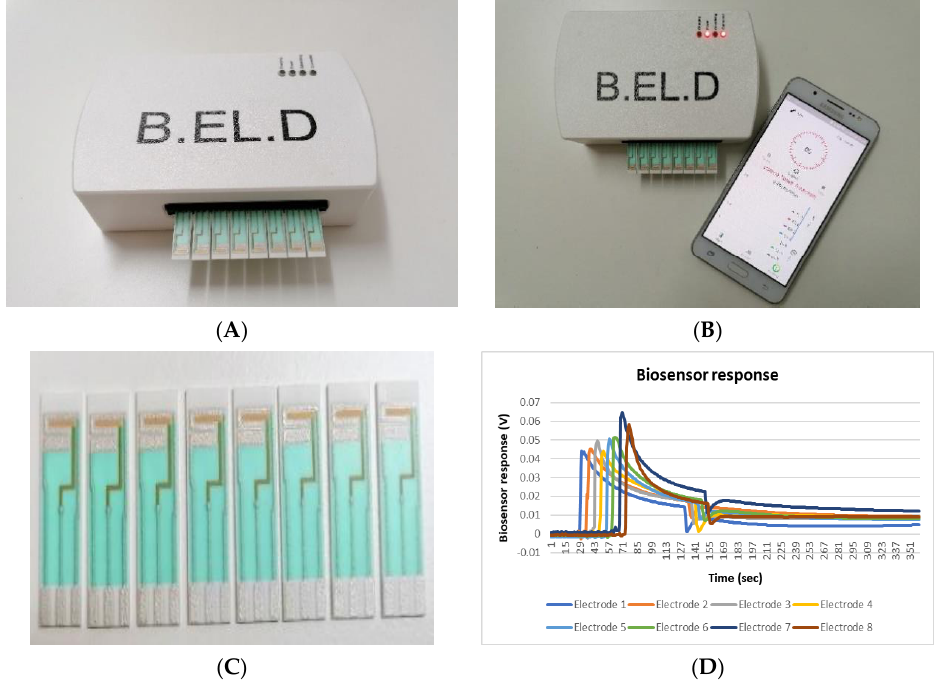
Figure 1. ( A ) Loading of the cells and samples on the electrode surface; ( B ) Results appear on the smartphone screen; ( C ) Screen-printed electrode sensors used for the assay, Zimmer and Peacock gold single electrodes; ( D ) Visualization of the electric signal via a voltage (Volts) vs. time graph.